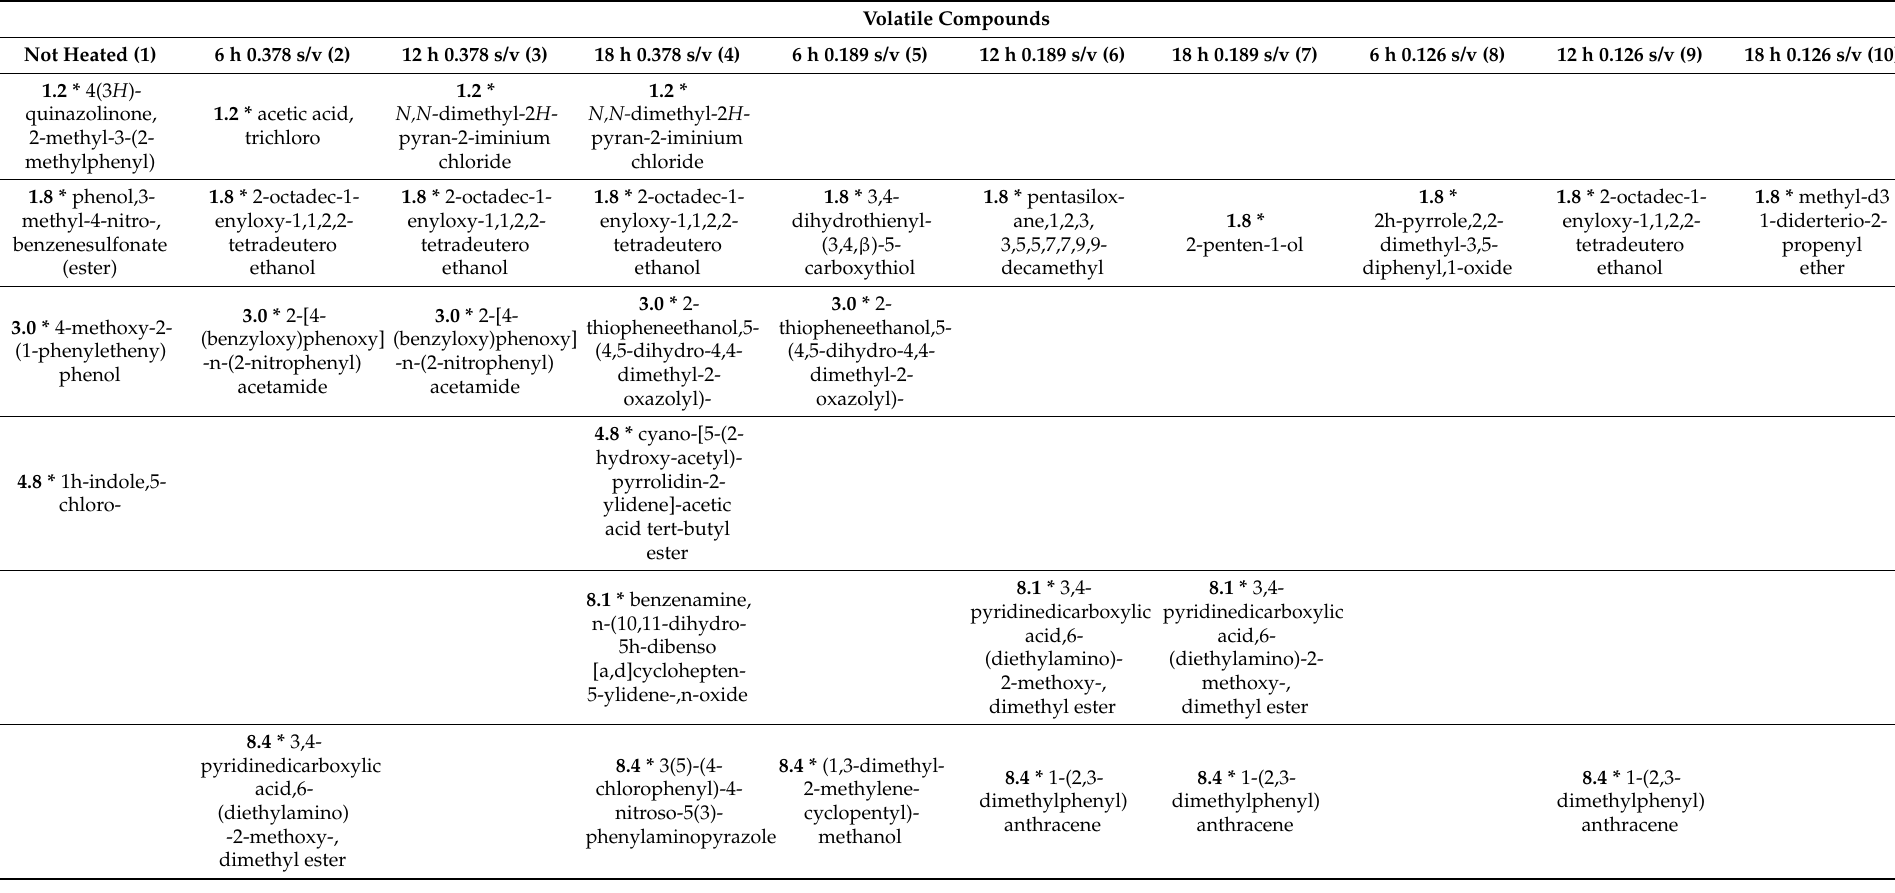
Table 2. Volatile compounds identified by GC-MS analysis of heated